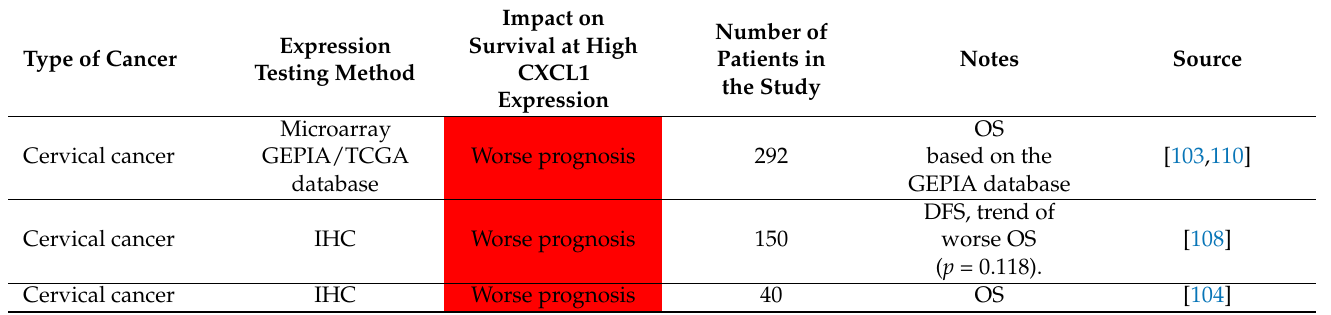
Table 2. Effect of CXCL1 expression level on survival of cervical cancer patients.